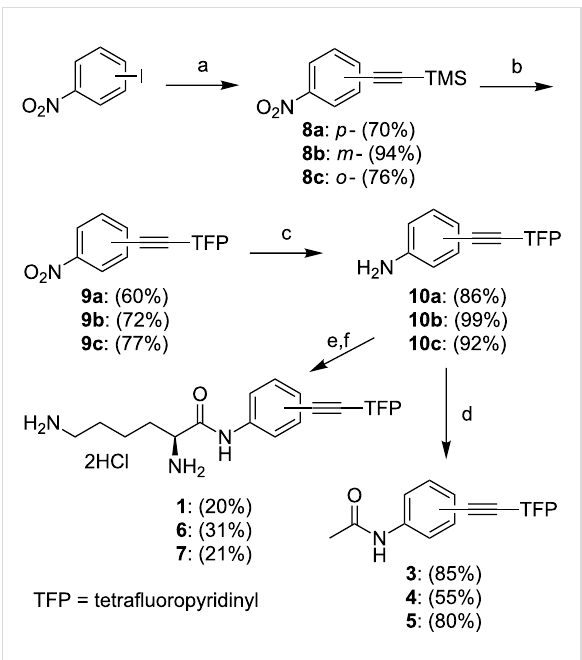
Scheme 2: Synthesis of amido-substituted monoacetylenes and lysine conjugates. Reagents and conditions: a. PdCl 2 (PPh 3 ) 2 , CuI, HCCSiMe 3 /Et 3 N, rt; b. CsF, pentfluoropyridine/DMF; c. SnCl 2 , EtOH, reflux; d. (CH 3 CO) 2 O, Et 3 N/CH 2 Cl 2 ; e. POCl 3 , Boc-Lys(Boc)-OH/pyri- dine; f.